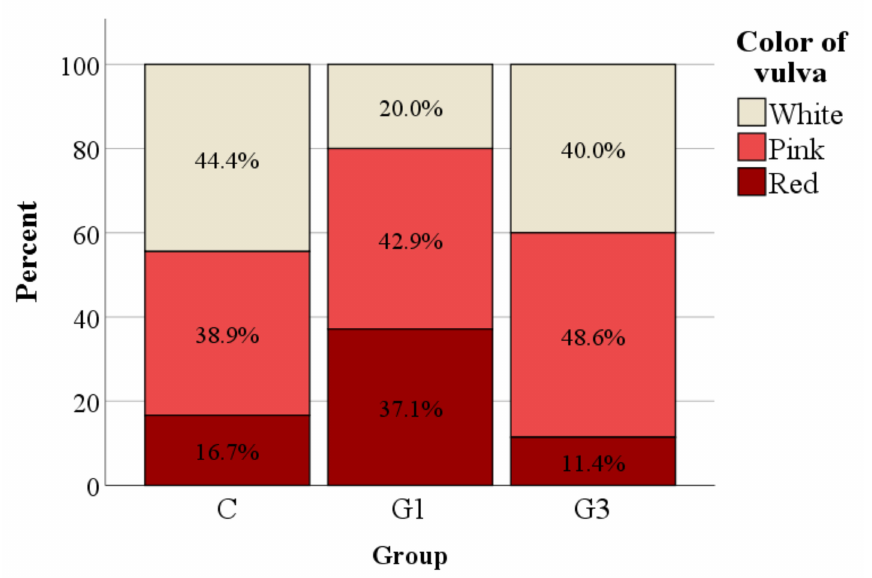
Figure 3. Relative frequency distribution of the color of the vulva used as an indicator of sexual receptivity in does of the control group (C) and does supplemented with 1% (G1) or 3% (G3) of Goji.